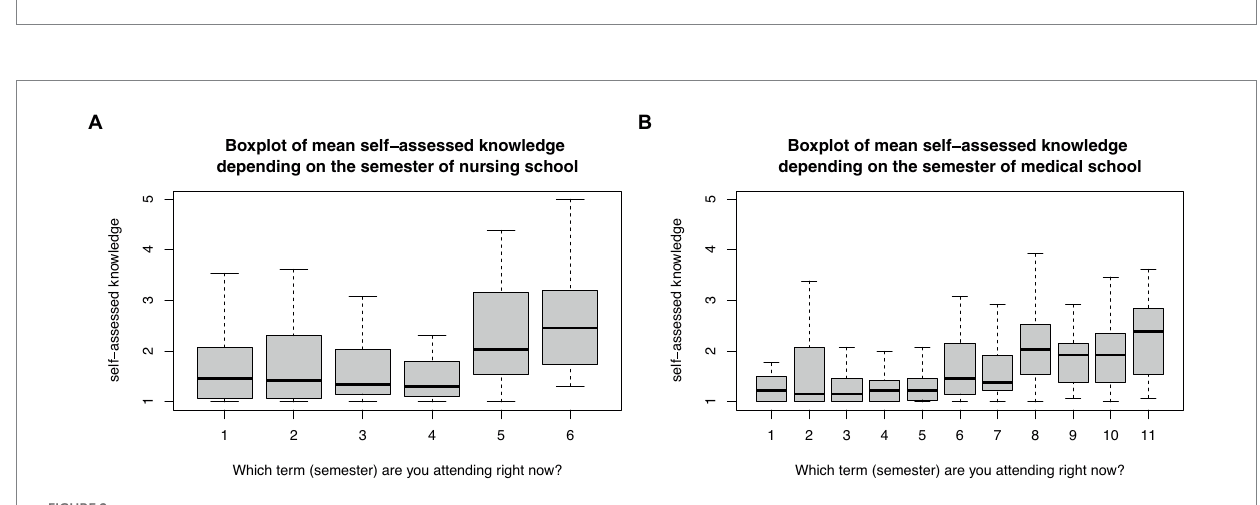
nursing colleges of Umeå and Gothenburg University ( t -test, p < 0.001), Umeå and Blekinge Technical University ( t -test, p < 0.01), and Umeå and Linné University ( t -test, p = 0.03), differences in self- were identified (Figure 5).